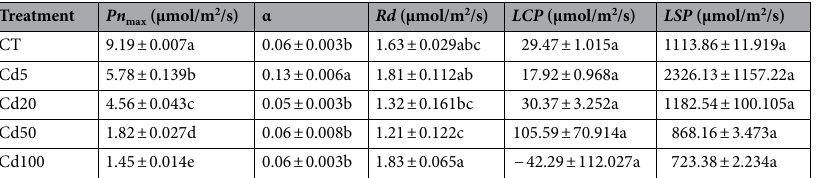
Table 2. Photosynthetic light-response parameters. Pn max : Maximum net photosynthetic rate; α: Initial quantum efficiency; Rd : Dark respiration rate; LCP : Light compensation point; LSP : Light saturation point. R 2 : 0.94–0.99. Different lowercase letters in the same column indicate significant differences between treatments with different cadmium